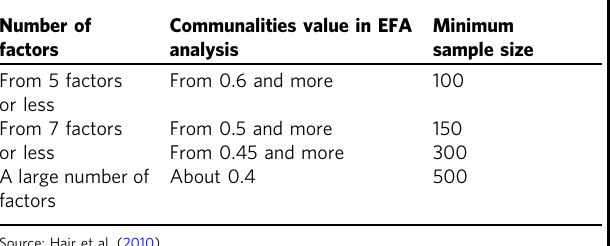
Table 3 Sampling criteria for SEM